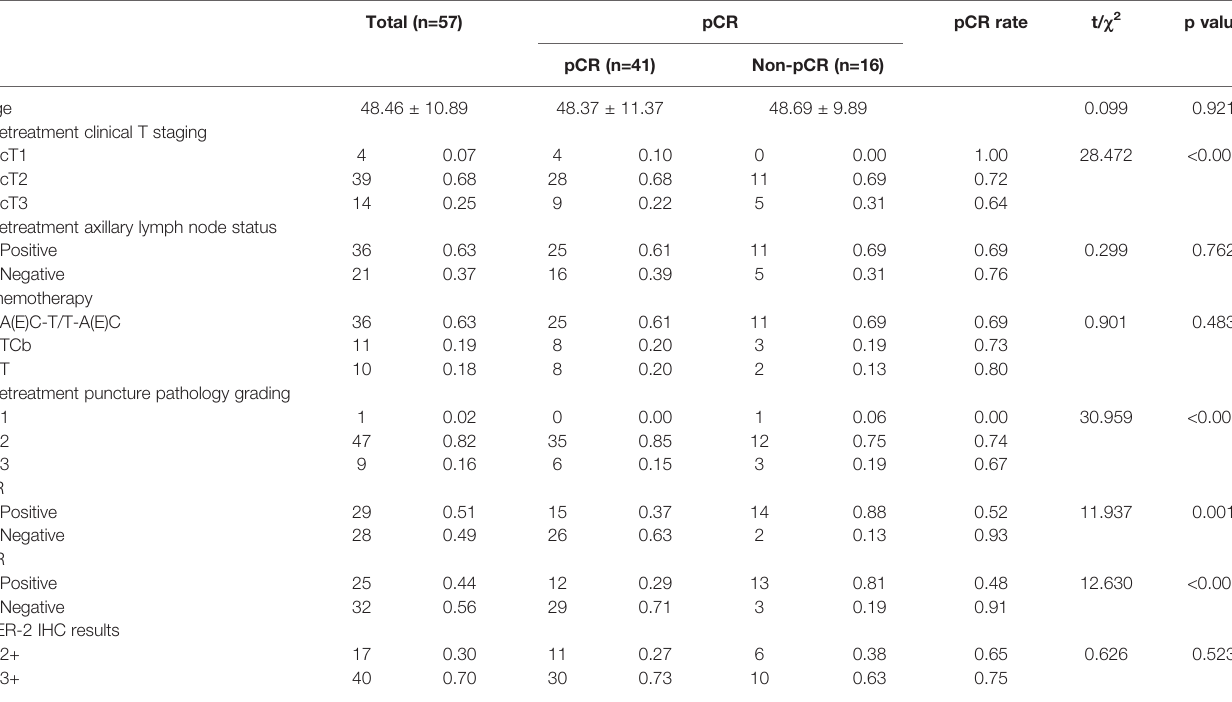
TABLE 1 | Baseline characteristics and pCR of 57